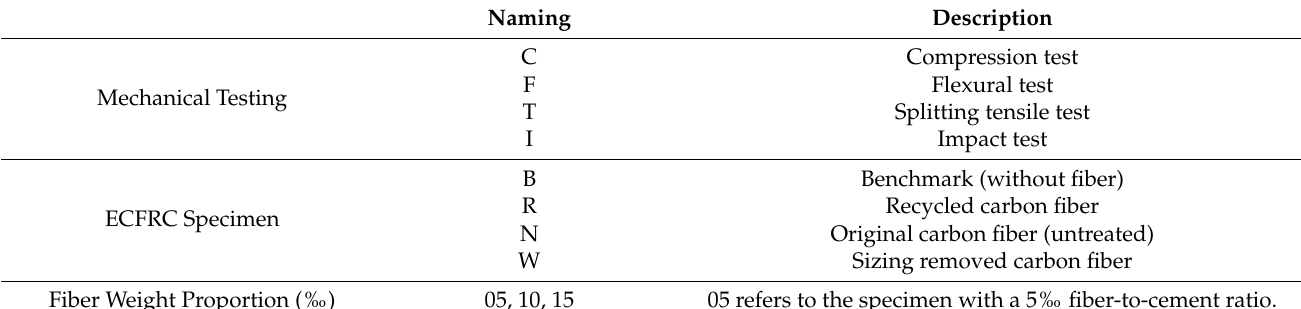
Table 3. Naming and description of each specimen.